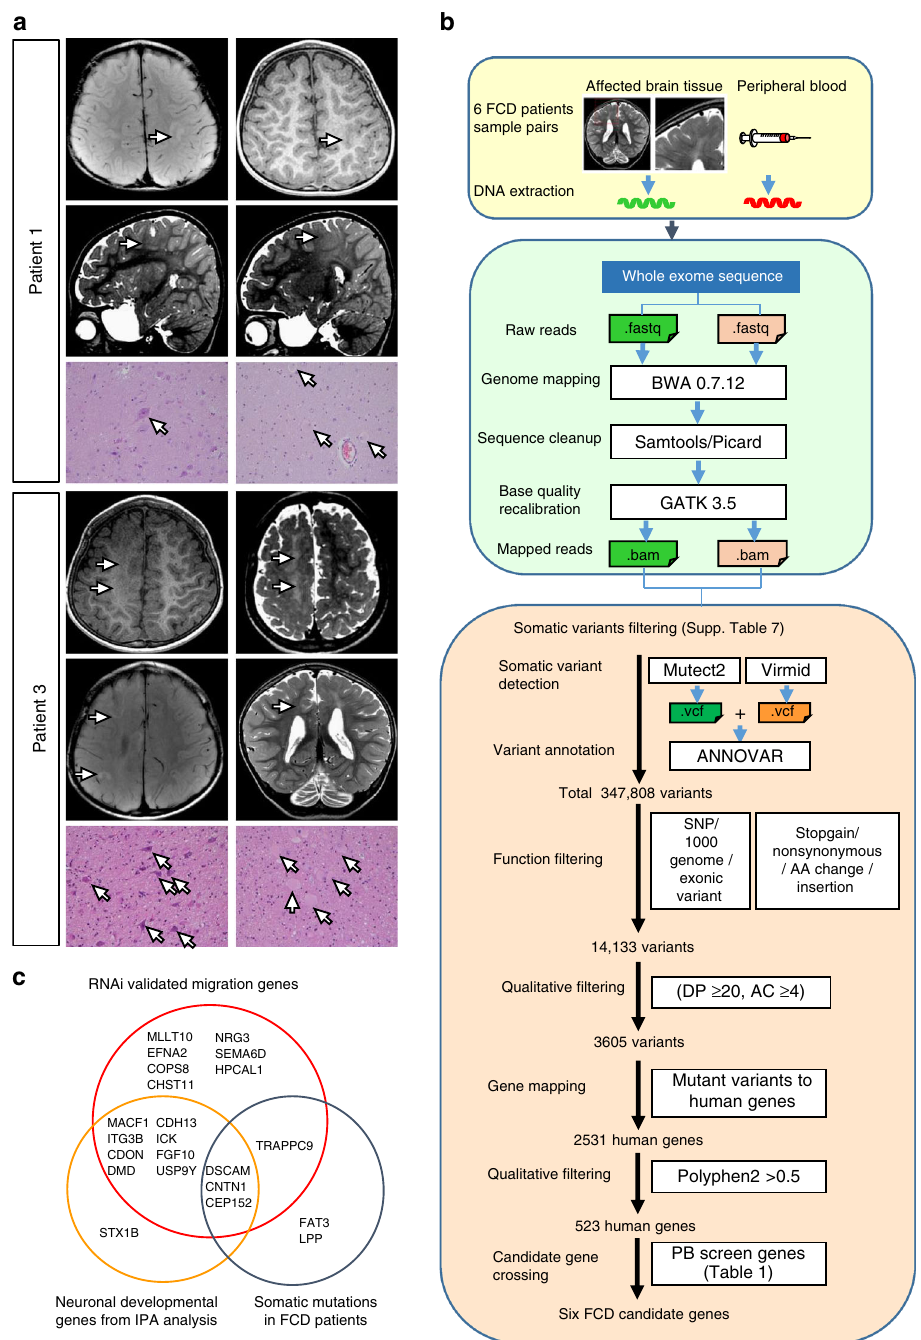
Fig. 4 WES analysis of somatic mutations in blood/tissue pairs from FCD II patients. a The pre-surgery brain T1 and T2 MRI images of two FCD II subjects showing the lesion sites (arrows). H&E staining of pathological samples showed dysmorphic and cytomegalic neurons (balloon cells) (arrows). b Flow chart of the WES pipeline and data analysis by the Virmid and MuTect algorisms. DP, Read depth, AC, alternative allele counts. c Overlap of gene mutations found in human FCD patients, genes involved in neural development from IPA analysis and genes validated using